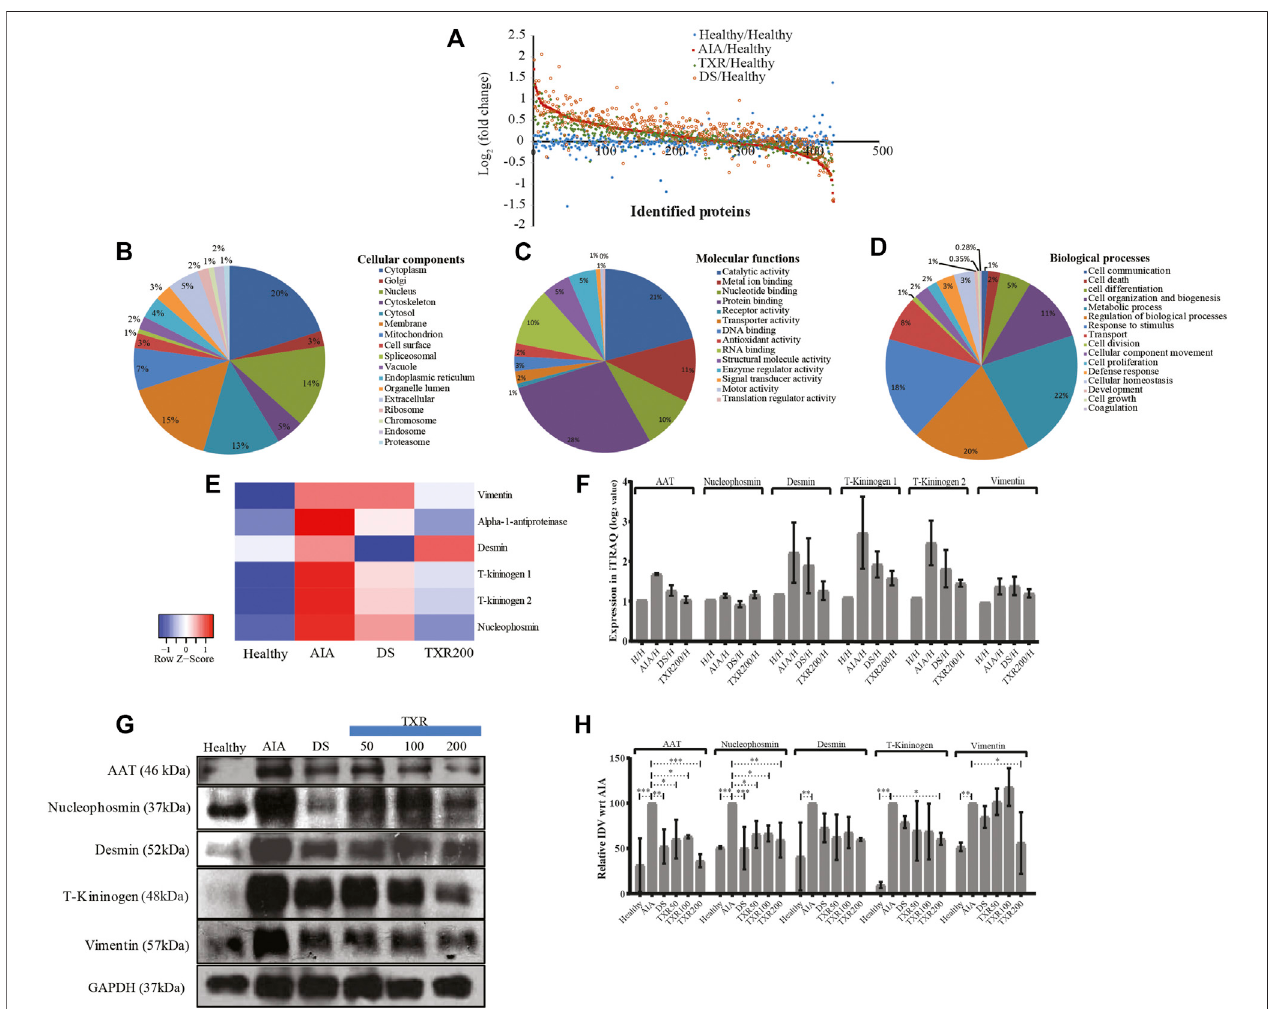
FIGURE4| Global proteomics assayoftissuejointhomogenateproteins ( n =434) intheexperimental studygroups. (A) The scatter plotsshowing alltheidenti fi ed proteins and their fold change values in the experimental groups. All the identi fi ed joint proteins were categorized according to cellular components (B) , molecular functions (C), and biological processes (D) . (E) Heatmap of important deregulated proteins that classi fi ed the study groups correctly. The color and its intensity explain the fold change values. (F) The iTRAQ ratios of the important deregulated proteins as observed in different study groups. (G) Western blot analysis of important markermolecules(alpha-1-antitrypsin,desmin, nucleophosmin,T-kininogen,andvimentin)andtheirrelativeintegrateddensitometricvalues(IDV)ofWesternblotbands (H) . The IDV of AIA was 100% constant against the other experimental samples.